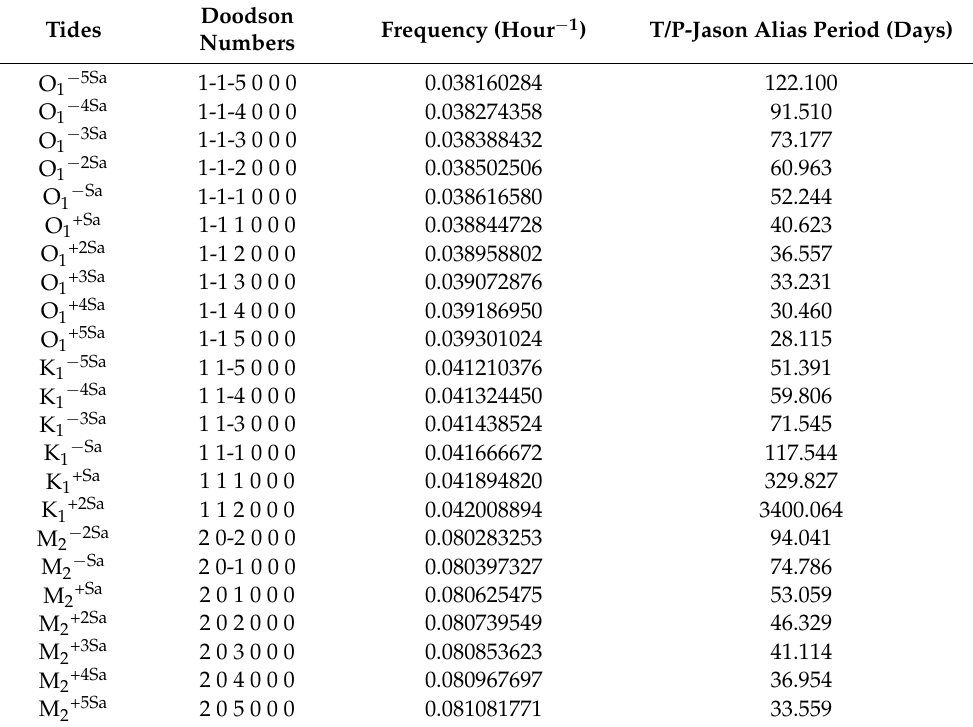
Table 4. Seasonal and subseasonal tidal constituents resolved by multi-satellite altimeter data. Alias periods are calculated using s_alias function in S_TIDE toolbox [2,15].